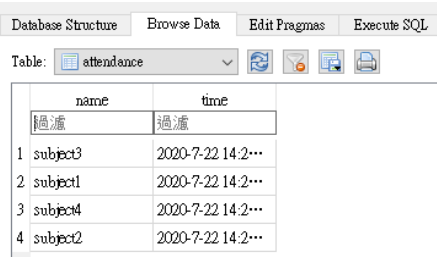
Figure 12. Roll call in SQLite which was sipped from the SQLite software results. The meaning of 過濾 is filter.